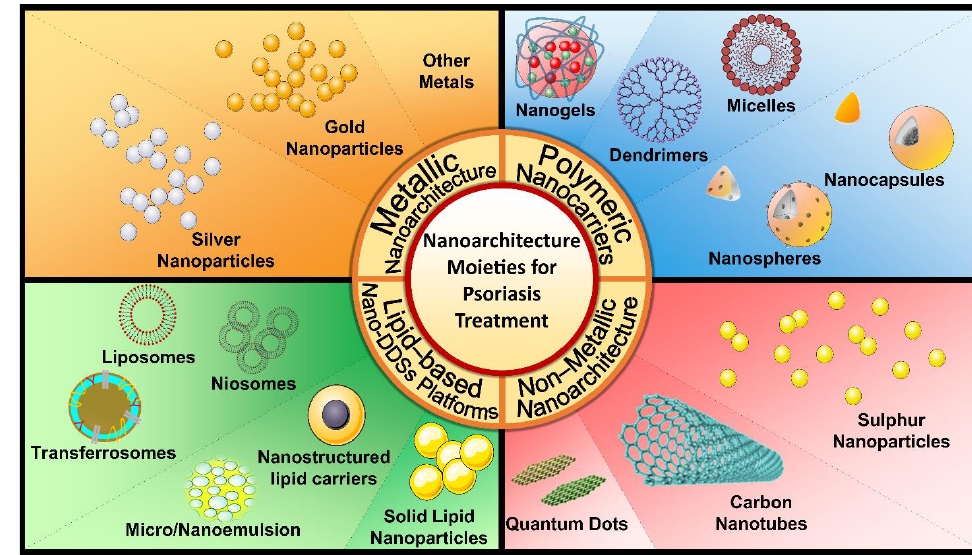
Figure 3. Nano-based drug delivery systems for psoriasis remediation. Lipidic systems, which comprise either a solid lipid core, mixed solid/liquid lipids,